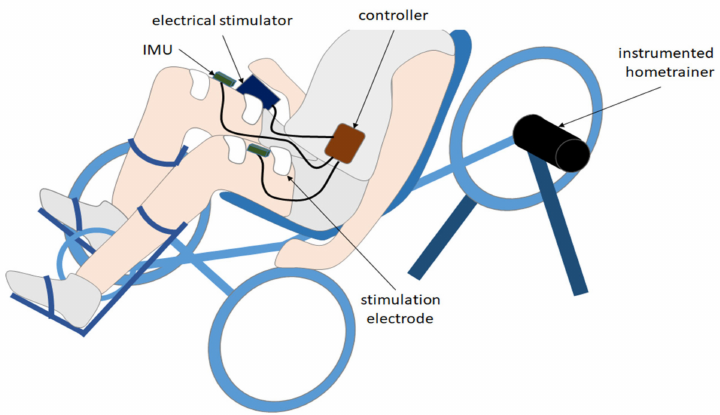
Figure 1. Experimental setup designed to validate the proposed approach. The pilot was equipped with 2 IMUs located on each thigh. IMUs were wired to a Raspberry Pi3 © (the controller) communicating with an electrical stimulator. An instrumented home trainer was set on the rear wheel to monitor power output during the